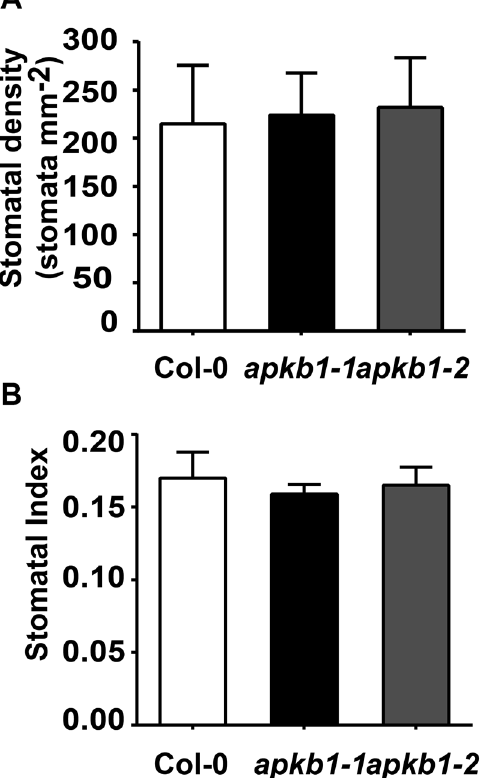
Figure 3. Stomatal density and index of apk1b-1 and apk1b-2 are similar to those of control plants. A: Stomatal density and B: stomatal index were calculated from the abaxial surface of fully expanded leaves. Error bars represent the standard error.